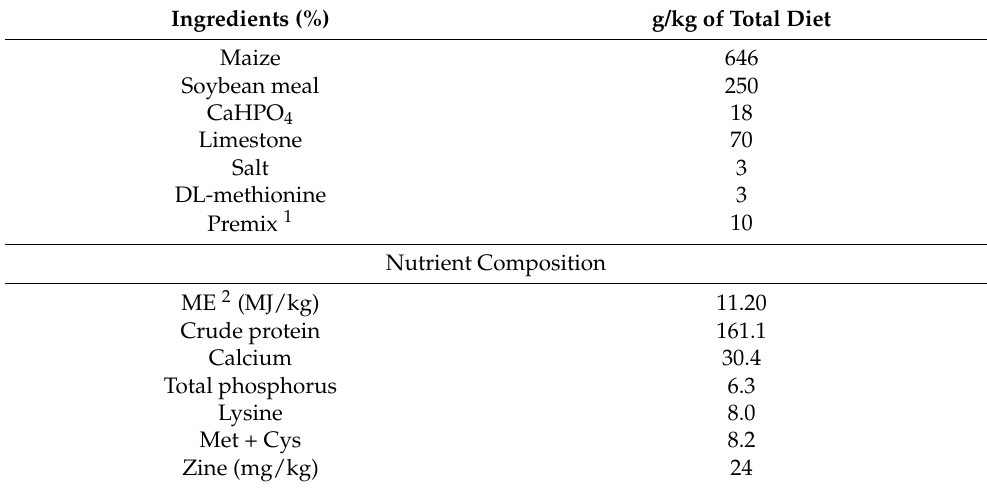
Table 1. Composition and nutrient level of the basal diet (g/kg, unless otherwise